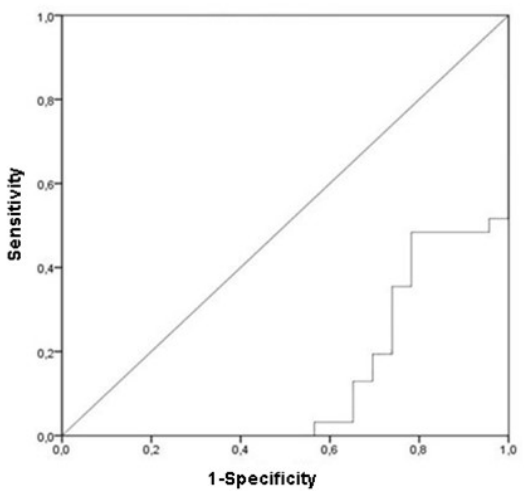
Fig. 2. Receiver operating characteristic (ROC) curve for miR-4270 yielded an AUC value of